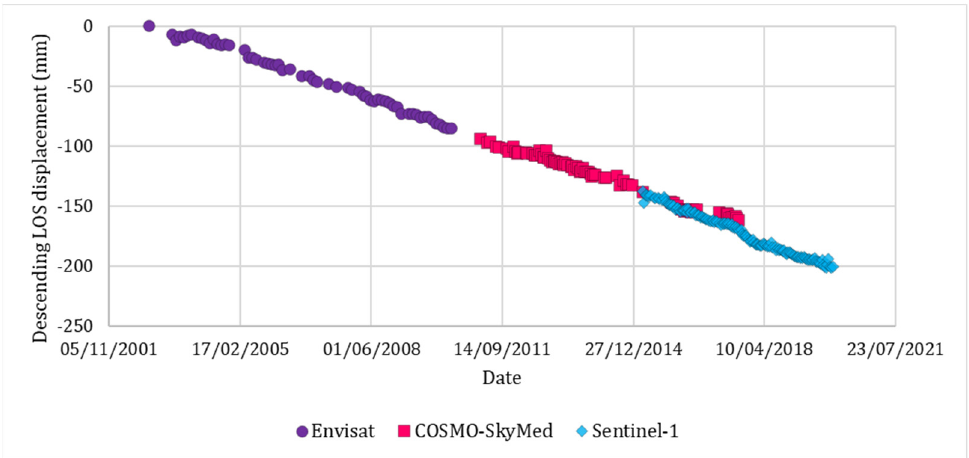
Figure 12. LOS displacement time series performed at the centre of the maximum deformation area detected by the totality of the elaborations and conducted with all available descending datasets: Envisat from 11/2002 to 06/2010 (purple circles), COSMO-SkyMed from 02/2011 to 08/2017 (pink squares) and Sentinel-1A from 01/2015 to 12/2019 (light blue diamonds).